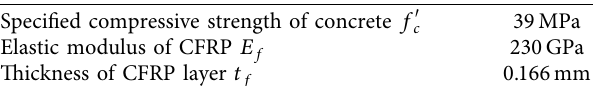
Figure 18: Shear stress in XY direction throughout the beam A2.5RC10/10. Table 9: Mechanical properties for concrete and CFRP composites